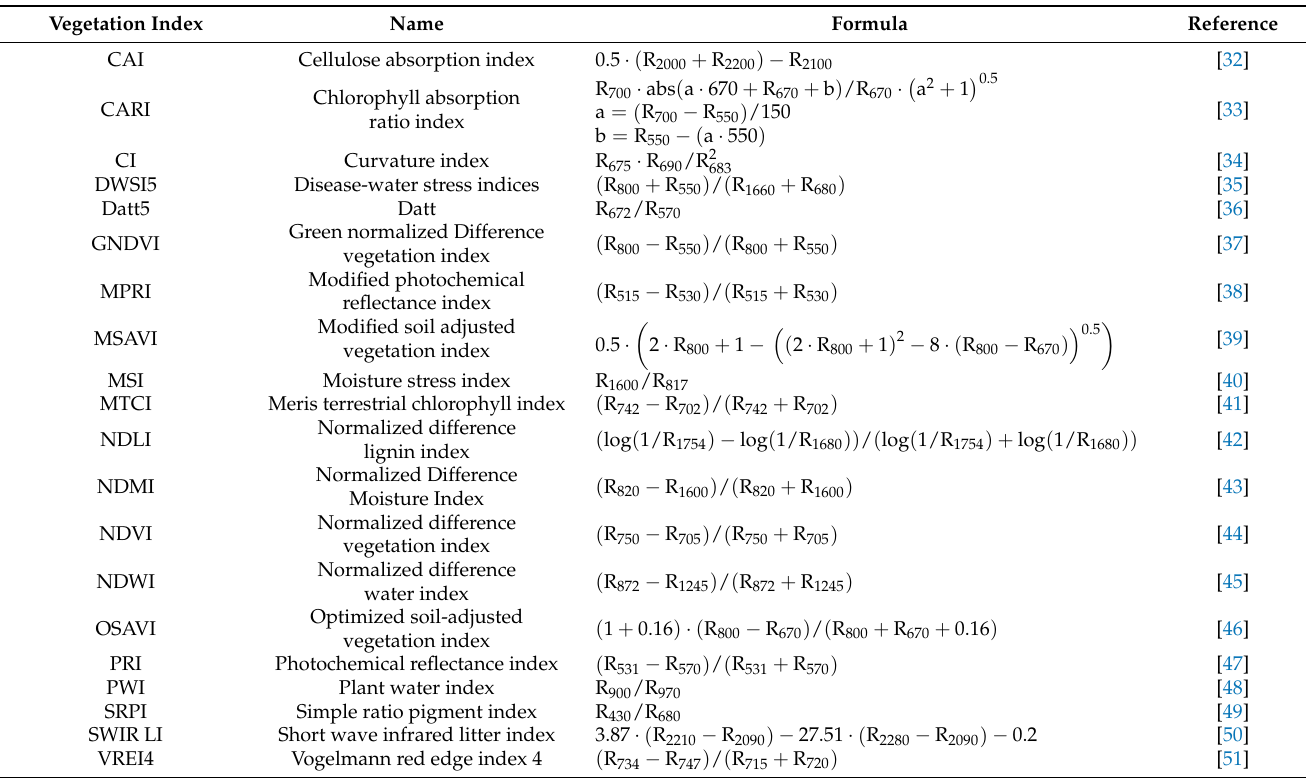
Table 1. Vegetation indices used in this